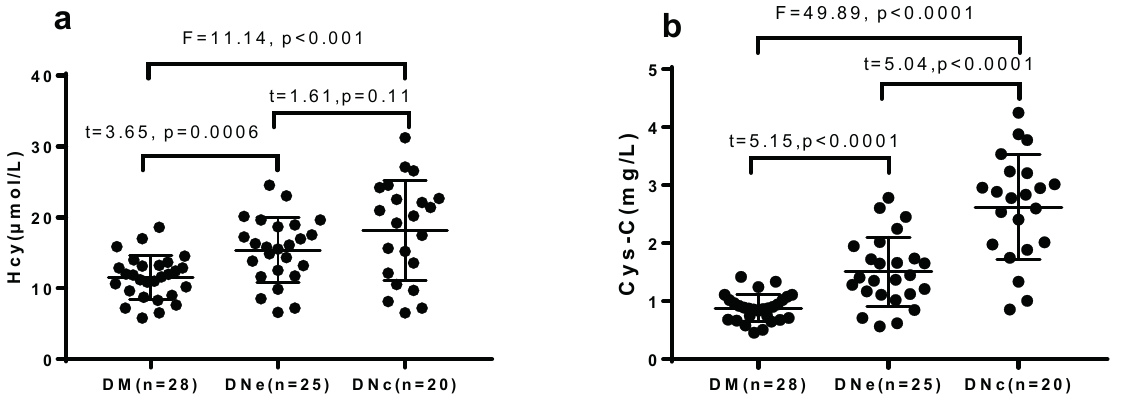
Figure 1: Scatter plot of serum homocysteine and cystatin C in type 2 diabetes mellitus, early diabetic nephropathy and clinical stage diabetic nephropathy groups (a: serum homocysteine distribution; b:serum cystatin C distribution)